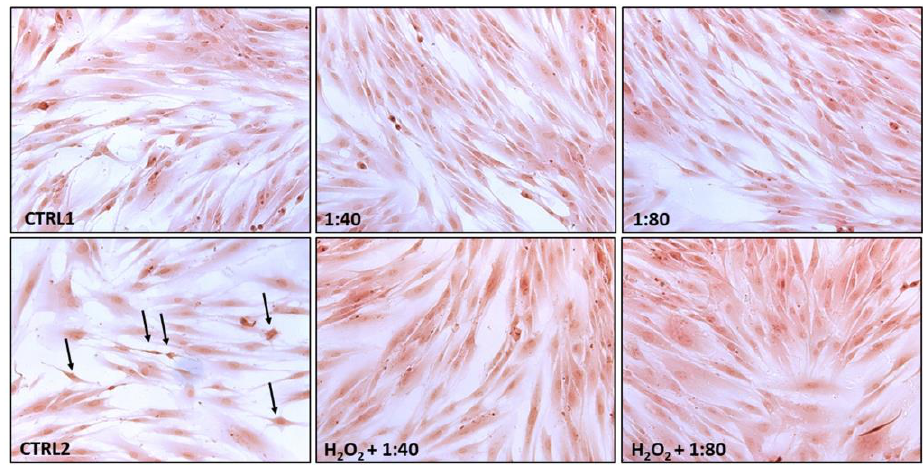
Figure 4. Hematoxylin/eosin staining of HGFs exposed for 24 h to DMEM culture medium (CTRL1), to SS diluted 1:40 and 1:80 ( upper panel), and of HGFs pre-treated with H 2 O 2 100 µ M for 3 h then exposed to DMEM culture medium (CTRL2) and to SS diluted at 1:40 and 1:80 ( lower panel). Black arrows indicate suffering cells close to the detachment. Magnification 20 × .